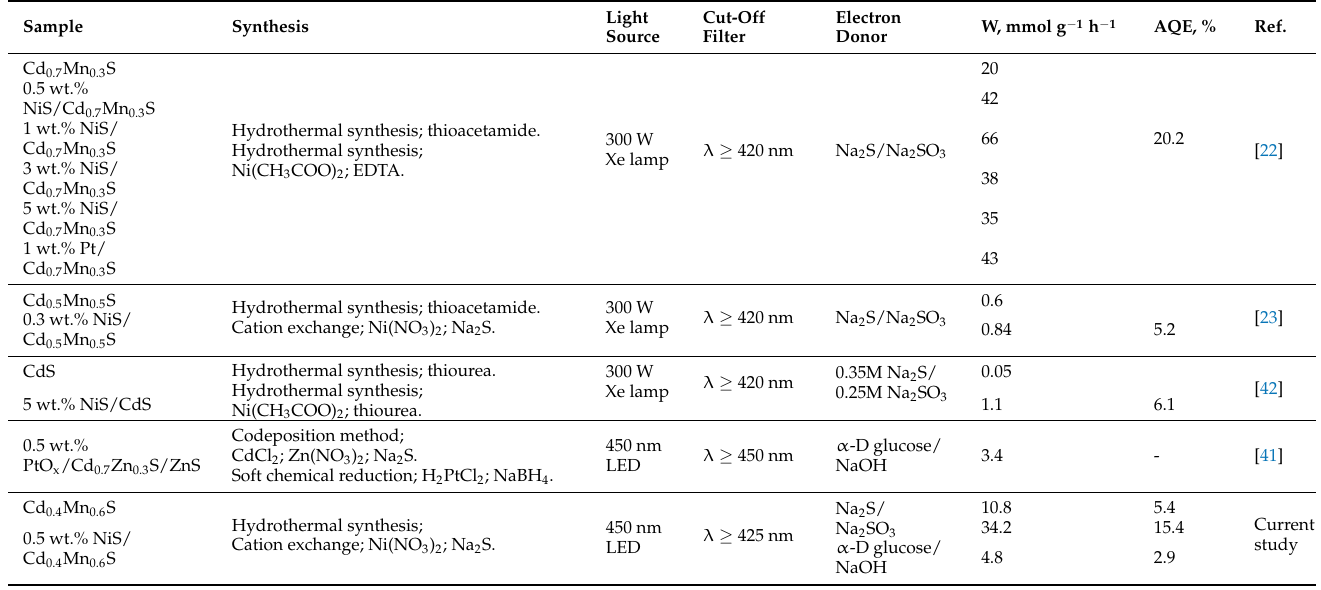
Table 4. The comparison of the activities of the synthesized samples with recently published